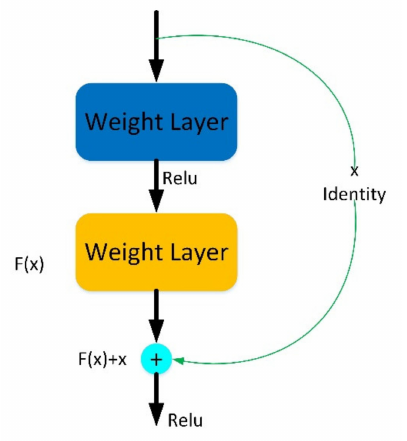
Figure 5. Residual